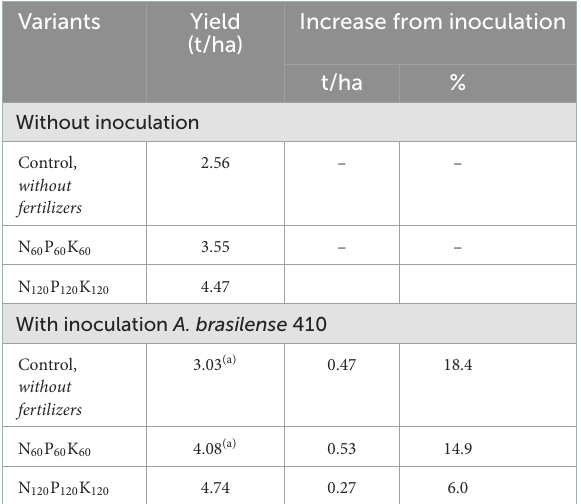
TABLE 2 The effect of fertilizers and pre-sowing seeds inoculation with A. brasilense 410 on spring barley yield (prorated to “per hectare” basis)